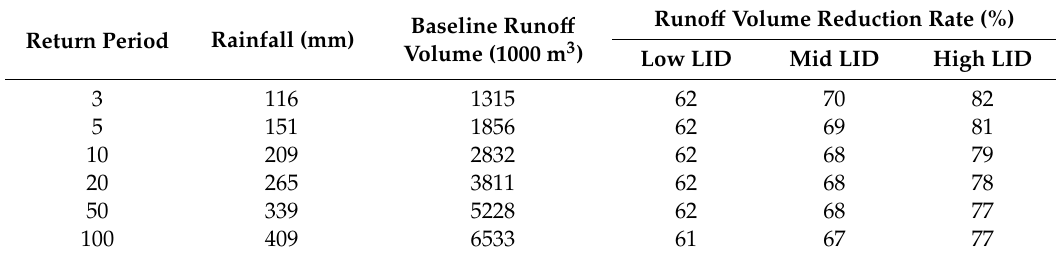
Figure 6. Event hydrographs at model outfall for Baseline and LID scenarios under 3 ( a ), 5 ( b ), 10 ( c ), 20 ( d ), 50 ( e ), and 100 ( f ) year 24 h Beijing design storms. Table 8. Modelled runo ff volume reductions relative to the Baseline scenario under varying 24 h return period events and levels of LID